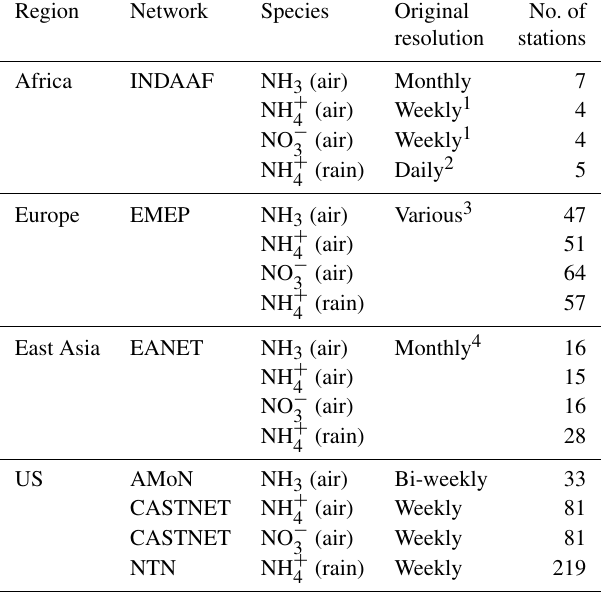
Table 2. Summary of the atmospheric monitoring network datasets used in this study. The number of stations shown is evaluated after screening for completeness (see text for